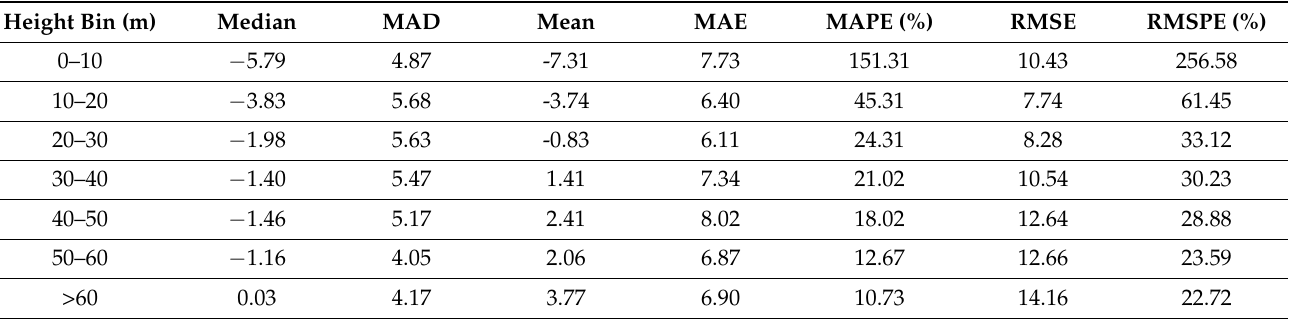
Table 4. Accuracy statistics of GEDI canopy height differences (ALS 95 , GEDI 95 ) of individual foot- prints (11,832) within different canopy height bins. Footprints were grouped using the ALS canopy height (RH95)